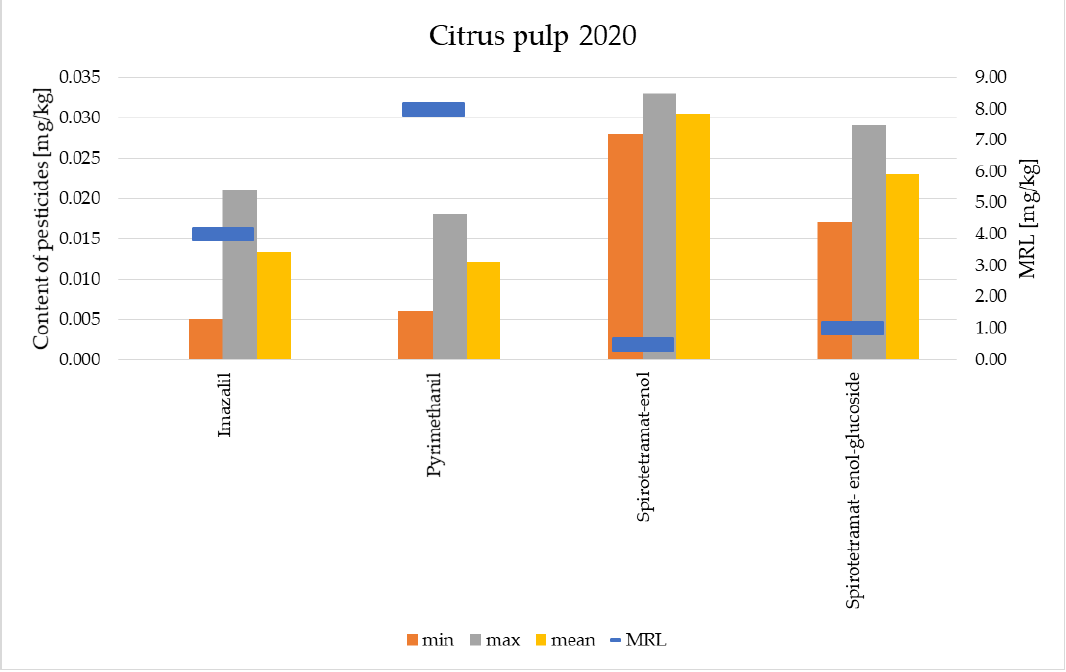
Figure 5. Content of pesticides from the edible parts of citrus fruits from the harvest of